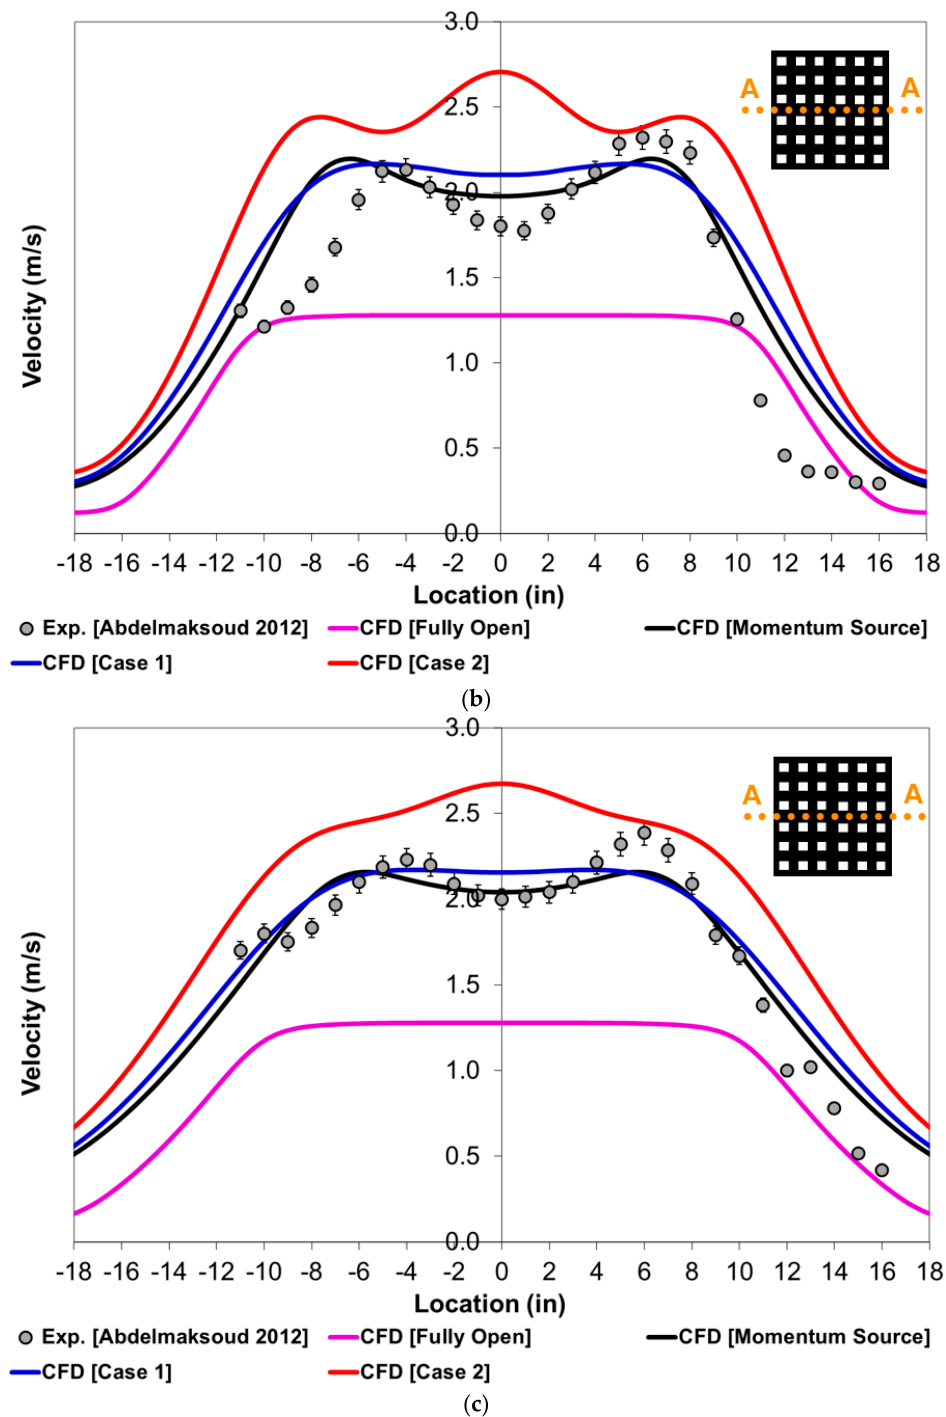
Figure 6. ( a )Tile flow distortion effect on velocity profiles at 1 ft height along line A ‐ A. ( b ) Tile flow distortion effect on velocity profiles at 2 ft height along line A ‐ A. ( c ) Tile flow distortion effect on velocity profiles at 3 ft height along line A ‐ A.